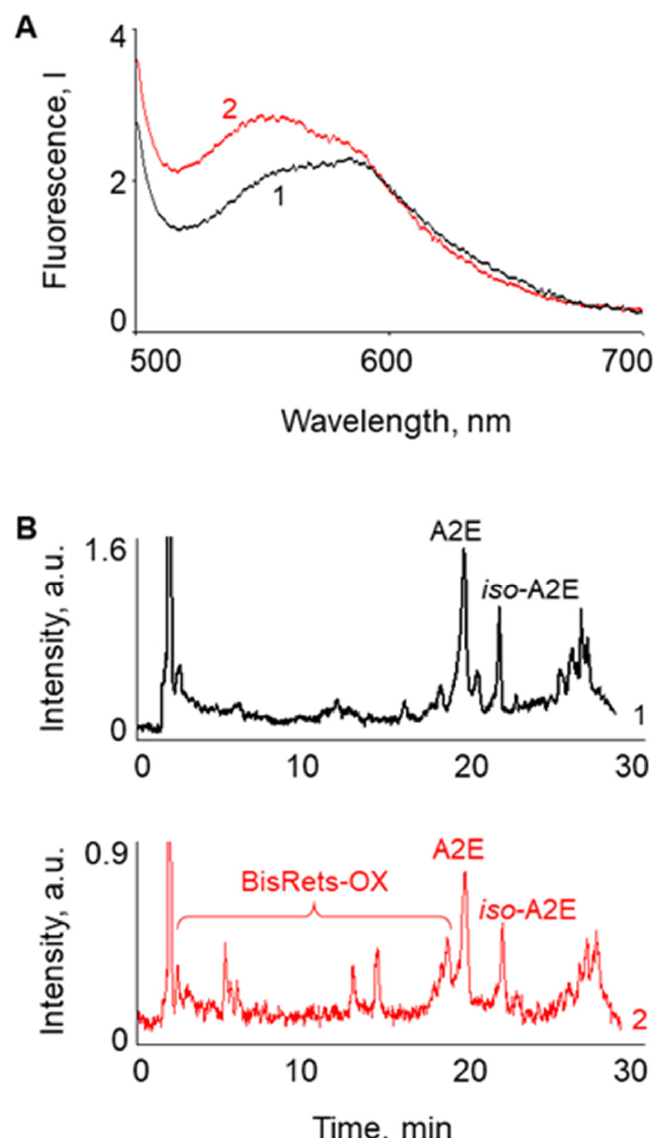
Figure 1. ( A ) Fluorescence spectra of lipofuscin granule (LG) suspensions: 1—native nonirradiated; 2—irradiated with visible light for 10 min. The wavelength of fluorescence excitation was 488 nm; spectra were normalized to the wavelength of 592 nm. ( B ) HPLC analysis of LG chloroform extracts: 1—from native nonirradiated LGs; 2—from LGs irradiated with visible light for 10 min. Detection was performed at the wavelength of 430 nm.